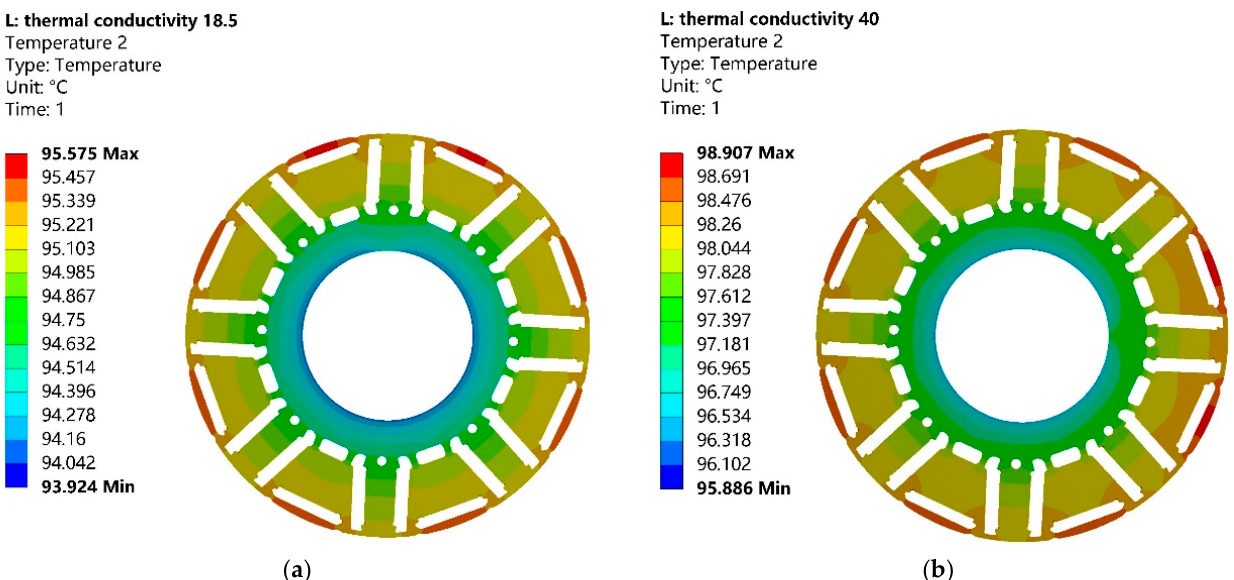
Figure 15. Temperature distribution of motor rotor cores of two materials at 19,000 r/min. ( a ) 10JNEX900. ( b ) 20SW1200H.